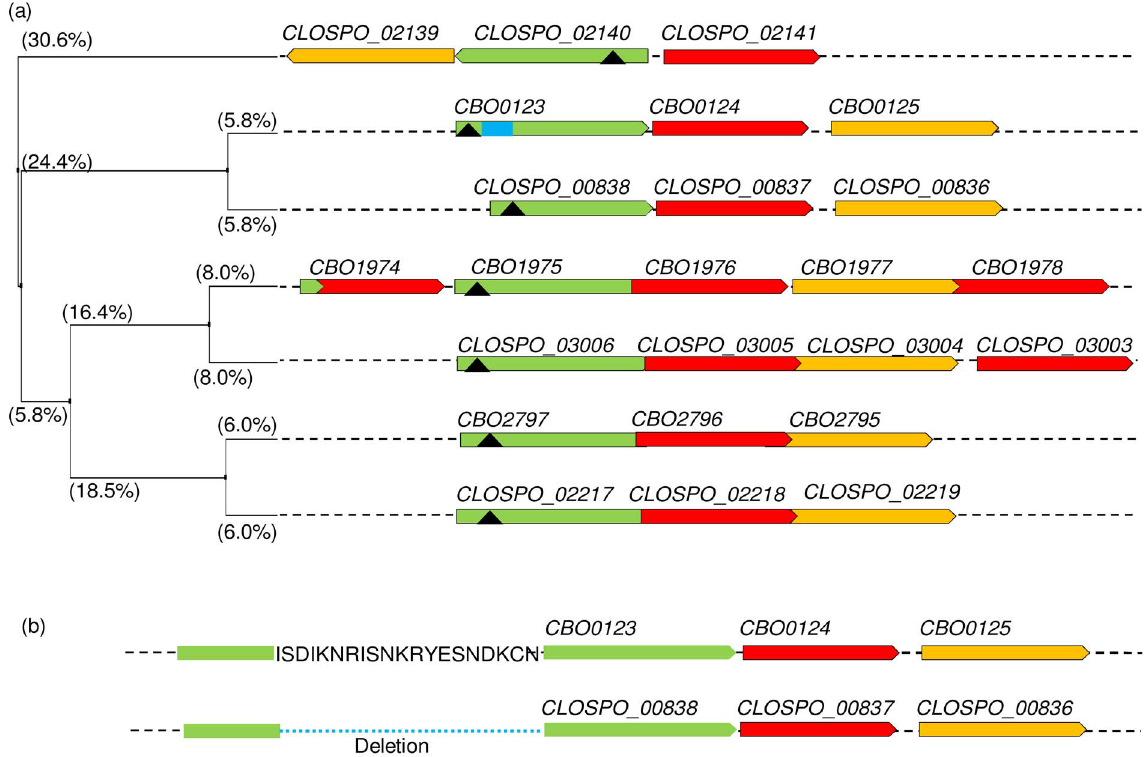
Figure 3. Alignment of C.botulinum and C.sporogenes germinant receptor proteins. Homologues of C. botulinum (strain ATCC3502) GRs were identified by BLASTp analyses using the draft un-assembled genome of C. sporogenes (strain ATCC15579). (a) Tree calculated (using Jalview [76]) from the pairwise sequence distances between GerXA only (determined from % sequence identities) of C. sporogenes (CLOSPO_number.) and C. botulinum (CBOnumber.) GRs, using the UPGMA algorithm [76]; average distances between GerXA (green) are shown on the branches. GerXB (red) and GerXC (yellow) are shown on the same tree (UPGMA produced identical-topology trees for each of the GerXB, GerXC proteins; distances not shown). (black triangle) Position of insertion sites of retargeted introns for mutations (in equivalent DNA sequence). Small green coloured region of CBO1974 represents a small protein fragment (CBO1973A), the coding sequence of which overlaps that of CBO1974, with homology to the C terminus of a GerXA protein. Blue square; 20 amino acid section that is deleted in its C. sporogenes homologue, CLOSPO_00838. (b) More detailed version of part of the above tree, showing the amino acid sequence encoded by a region in CBO0123 that is deleted from its C. sporogenes homologue,